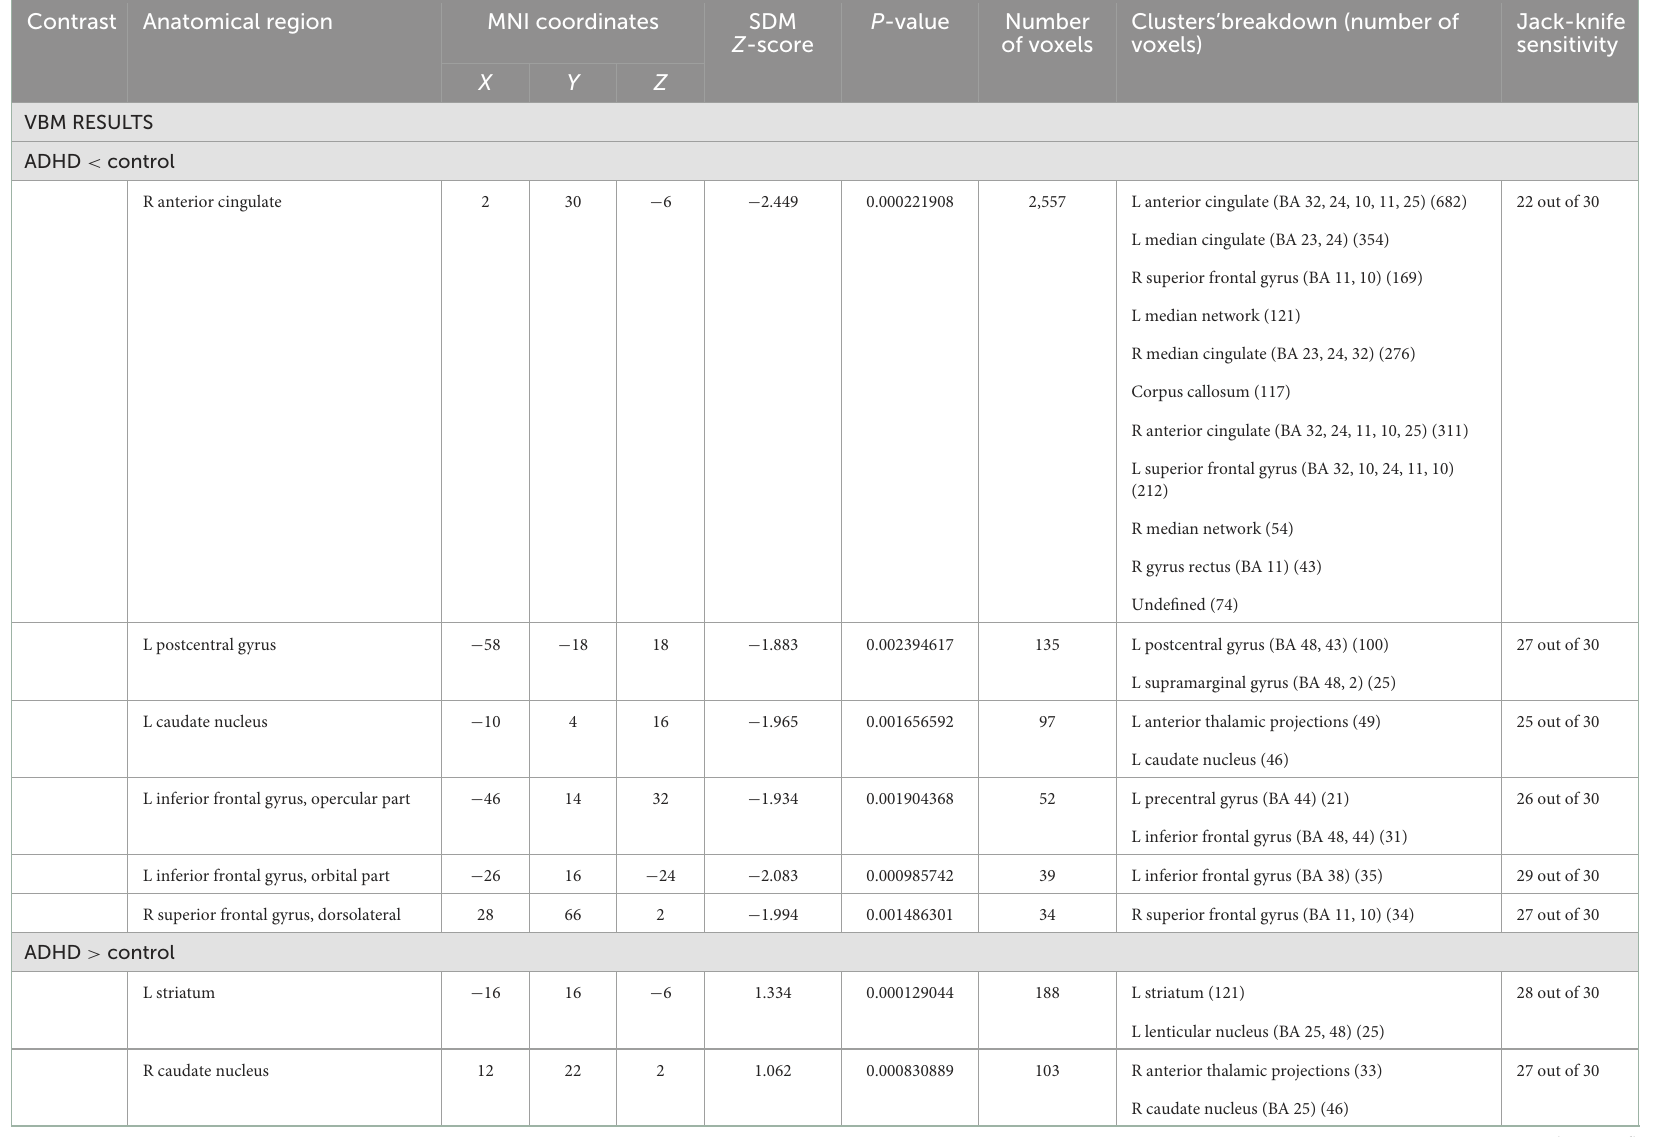
Number Z -score of